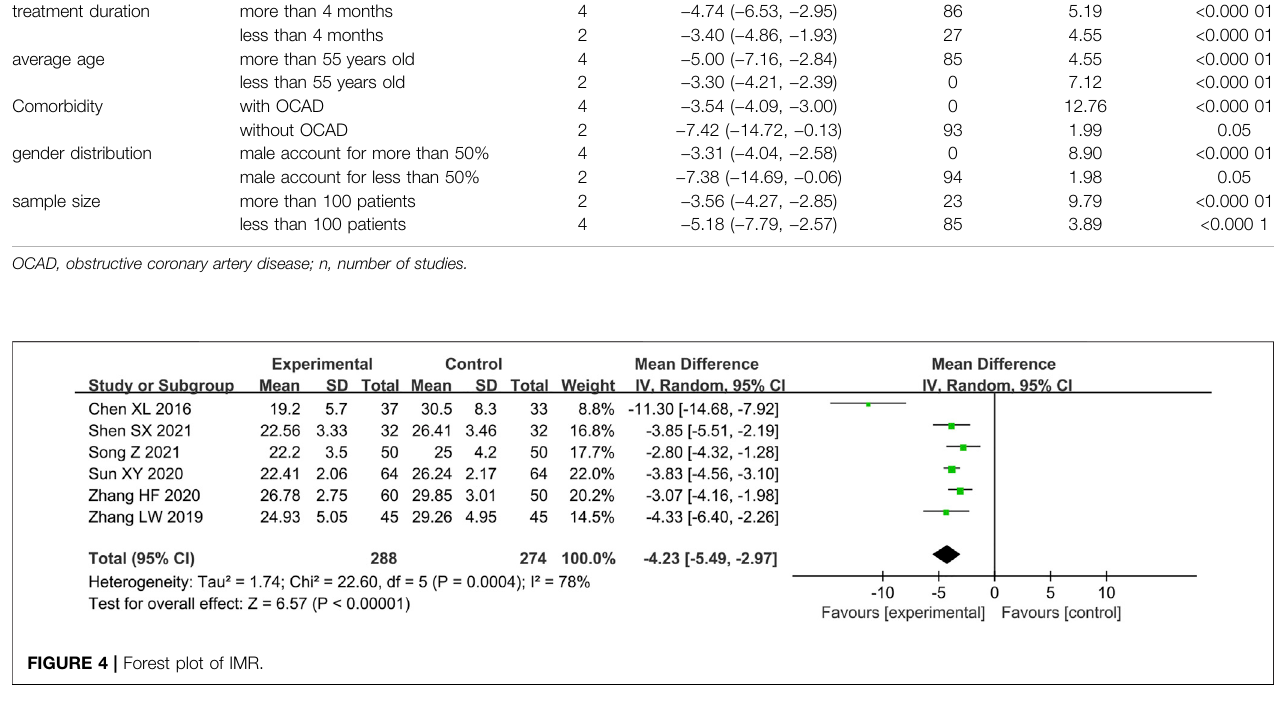
TABLE 4 | Subgroup analysis of NO based on treatment duration, average age, comorbidity, gender distribution and sample size. Criteria for grouping treatment